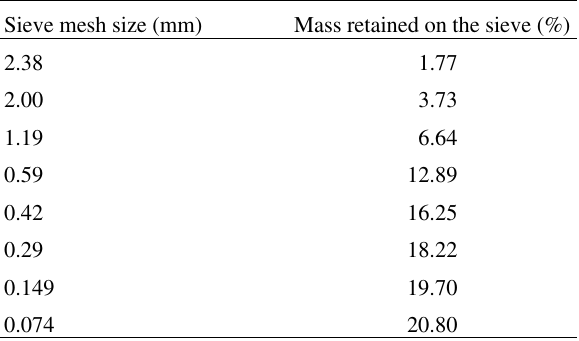
Table 2. Granulometric distribution of the solid grit waste. Sieve mesh size